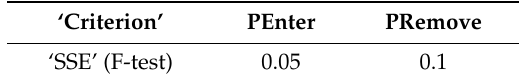
Table A5. Matlab toolbox LMSR parameter settings.